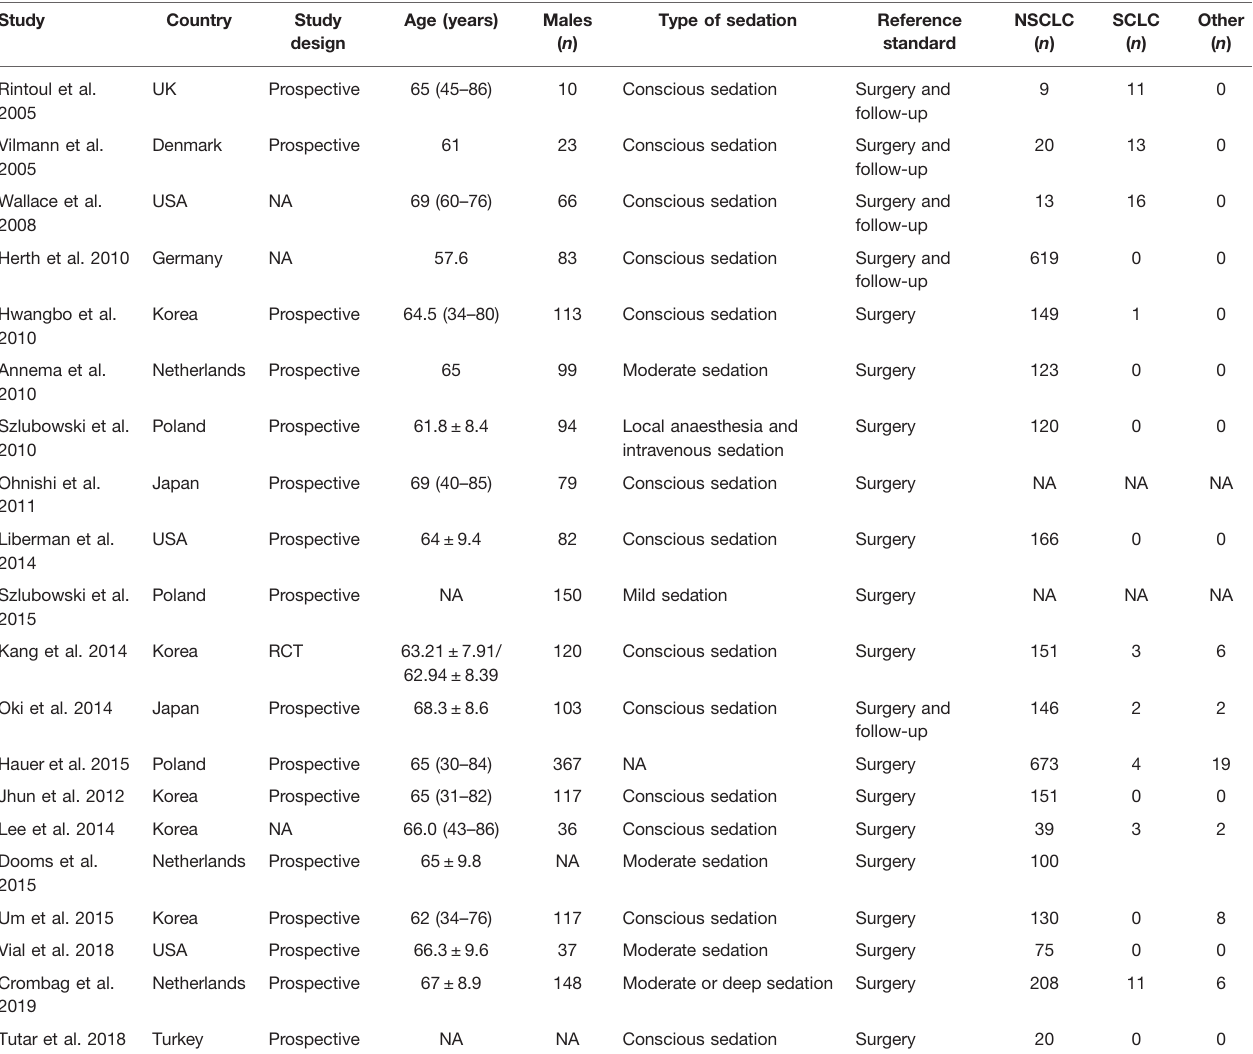
TABLE 1 | Characteristics of the included